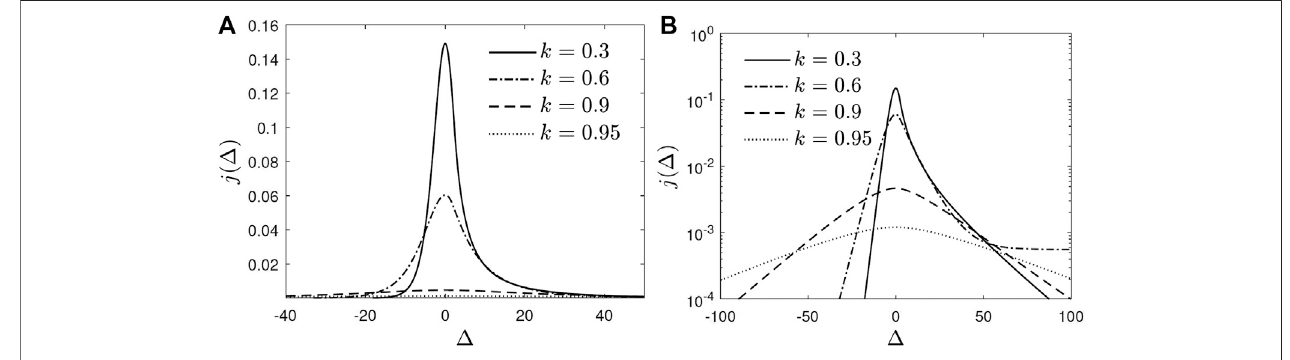
FIGURE 3 | Reduced differential rate j ( Δ ) of newly infected fraction corresponding to the cumulative J ( Δ ) shown in Figure 2 . (A) linear scale, (B) semilogarithmic